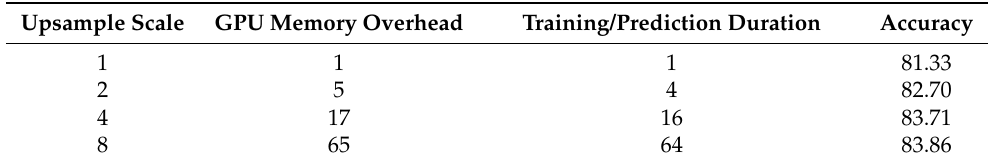
Table 7. The correspondence between upsample scale, GPU memory overhead, training/prediction duration, and accuracy on the LSC dataset.